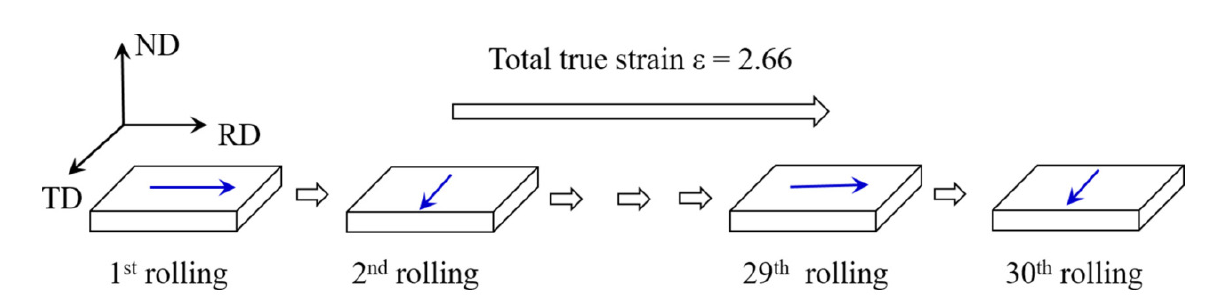
Figure 1: Schematic diagram of the multi-step cross cold rolling employed in the present